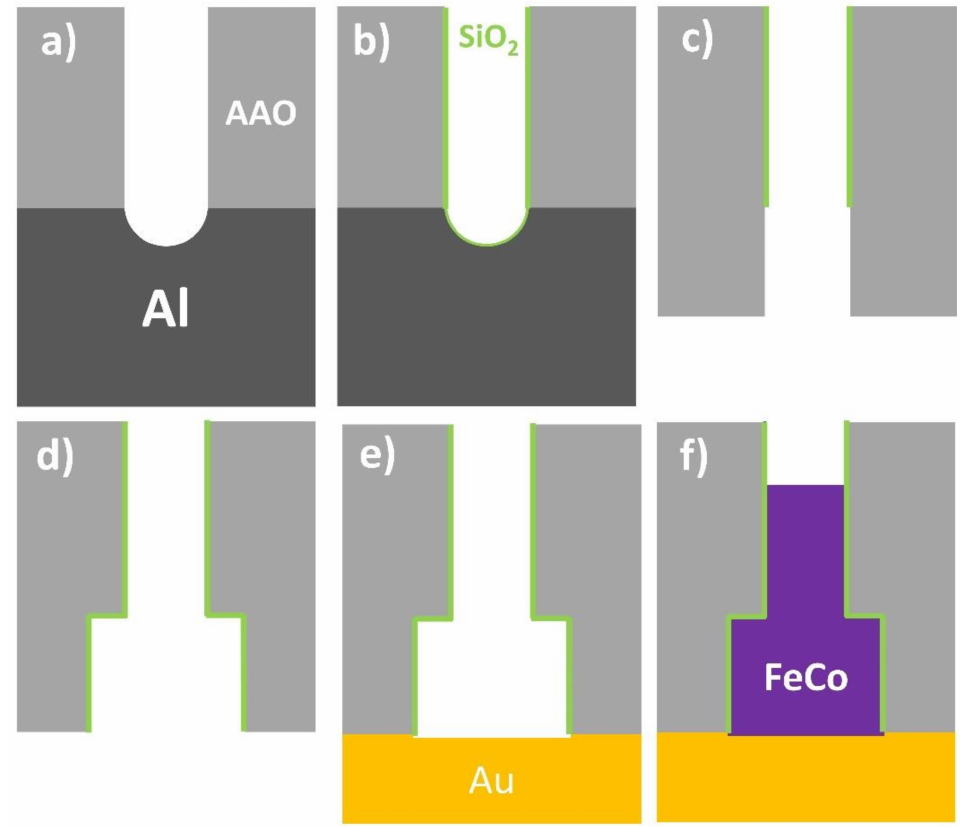
Figure 1. Schematic process flow for the fabrication of bisegmented diameter modulated nanowires embedded into the prepatterned nanopores of anodic aluminum oxide (AAO) template: ( a ) Hard anodization of the Al substrate. ( b ) Coating of AAO surface with a thin SiO 2 layer by ALD. ( c ) Reanodization of the coated AAO substrate and removal of Al substrate and alumina barrier layer. ( d ) Pore widening and SiO 2 layer coating. ( e ) Deposition of Au electrode by sputtering and subse- quent electrodeposition of Au layer. ( f ) Electrochemical deposition of bisegmented FeCo nanowires inside the patterned pores of the alumina